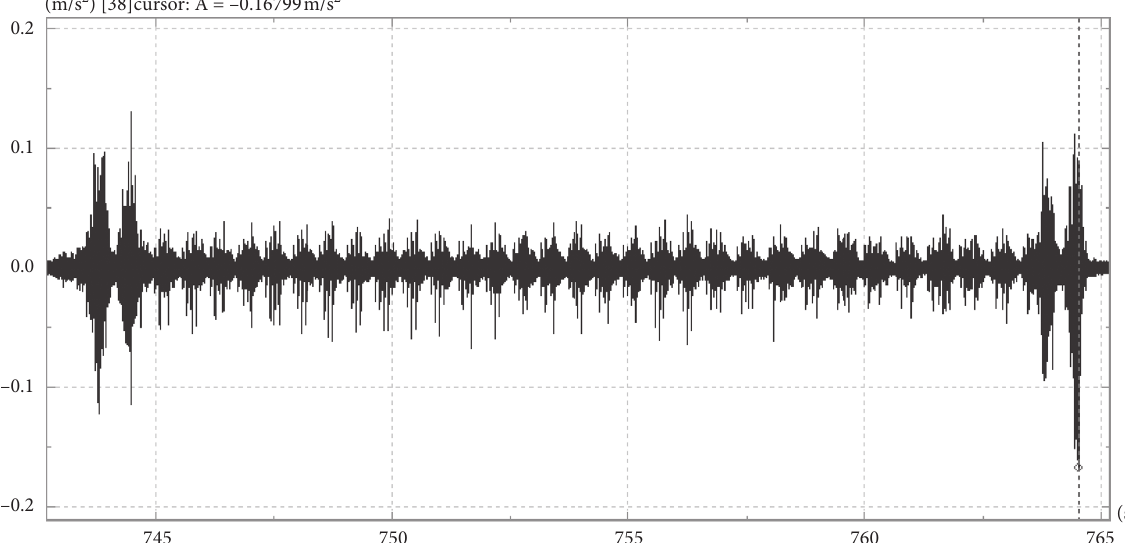
Figure 15: Time domain characteristic diagram of vibration acceleration along the line perpendicular direction ( X -axis) in the intact zone.